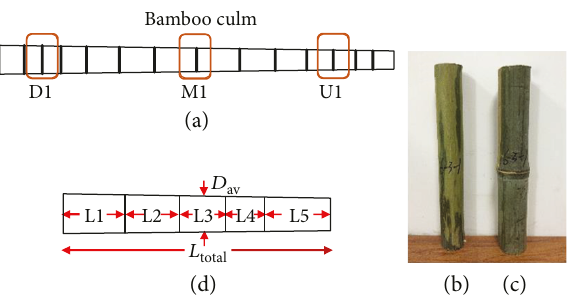
Figure 1: (a) Sample position; (b) internodal sample without node (INS); (c) nodal sample (NS); (d) dimension of nodal